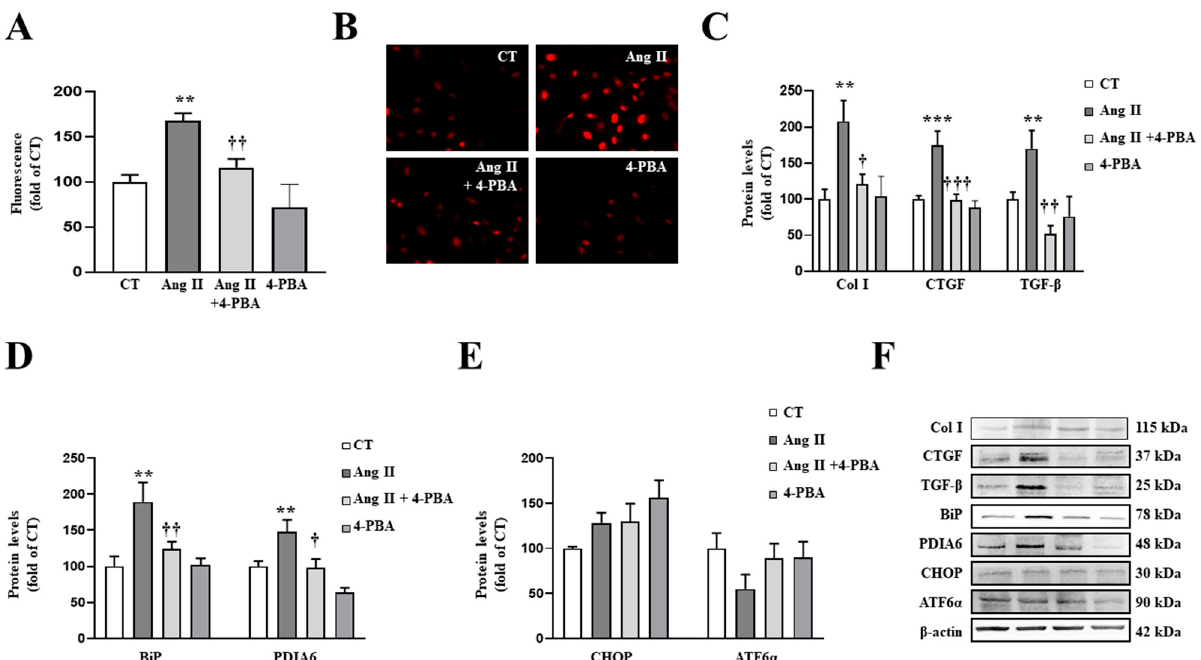
Figure 6. Endoplasmic reticulum stress mediates the prooxidant and profibrotic effects induced by Angiotensin II (Ang II) in vascular smooth muscle cells (VSMCs). ( A , B ) Effect of 4-phenylbutyrate acid (4-PBA; 4 µM) on superoxide anion production. Quantification of cells labelled with the oxidative dye dihydroethidium ( A ) and representative microphotographs (magnification 40×) ( B ). Protein levels of ( C ) collagen type I (Col I), connective tissue growth factor (CTGF) and transforming growth factor-beta (TGF- β ); ( D ) immunoglobulin binding protein (BiP) and protein disulfide isomerase family A member 6 (PDIA6); ( E ) CCAAT-enhancer-binding protein homologous protein (CHOP) and activating transcription factor 6-alpha (ATF6 α ) in VSMCs treated with Ang II (10 − 6 M) for 24 h. ( F ) Representative blots for protein expressions. Bars graphs represent the mean ± SEM of four to six assays normalized for β -actin. ** p < 0.01, *** p < 0.001 vs. control cells. † p < 0.05, †† p < 0.01, ††† p < 0.001 vs. Ang II-treated VSMCs.